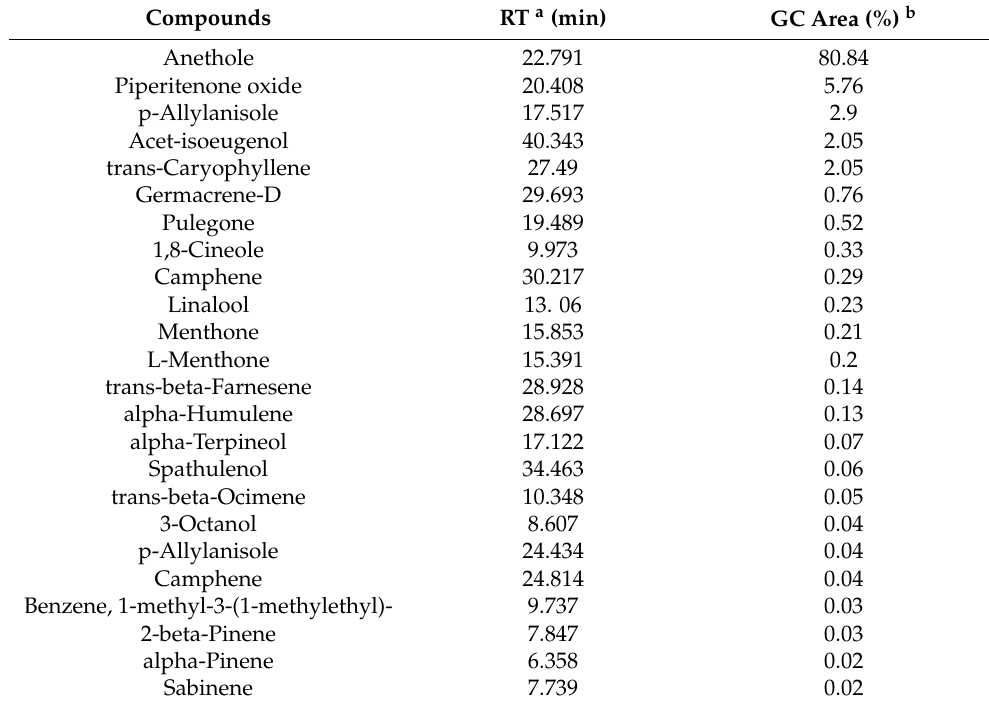
Table 1. The chemical composition of Pimpinella anisum essential oil.